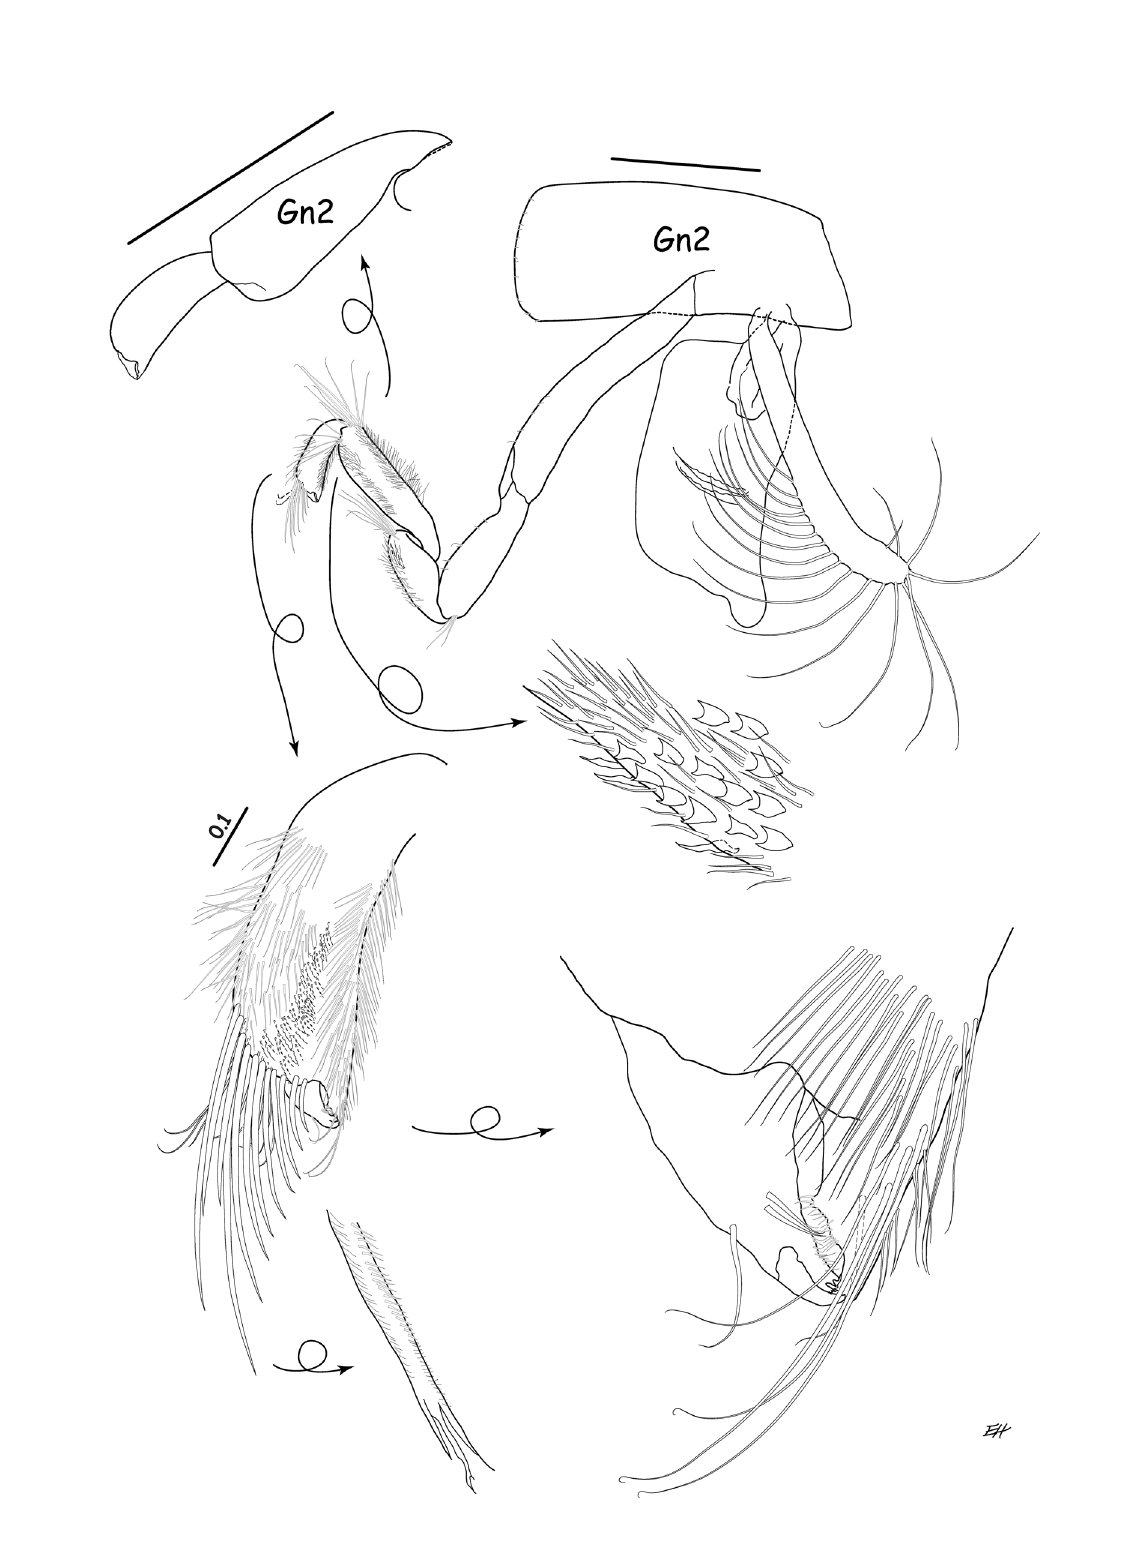
Fig. 23. Abyssorchomene scotianensis (Andres, 1983), ♀, 12 mm (CMNC 2022-0005). Setae omitted on Gn2 carpus-propodus detail at top left corner of figure. Scale bars = 1 mm unless indicated